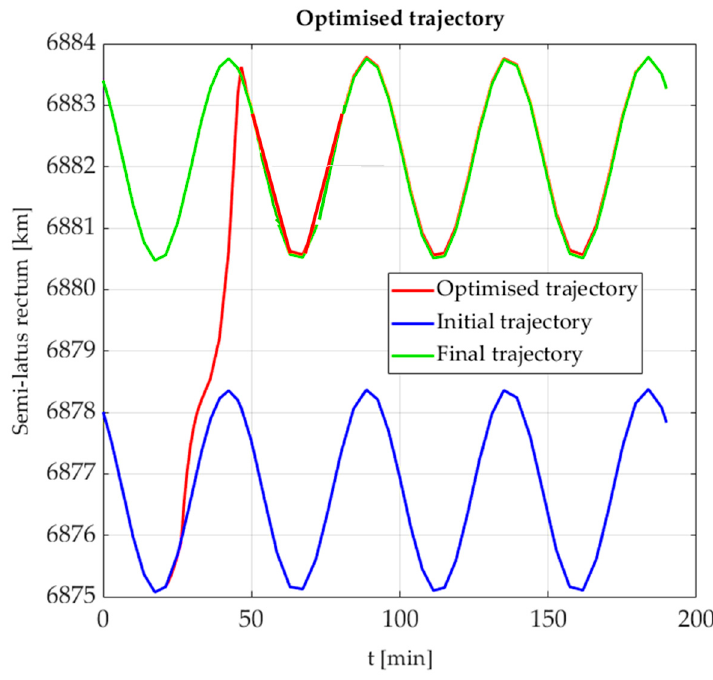
Figure 16. Change in semimajor axis from initial to final trajectory (ground-based scenario).